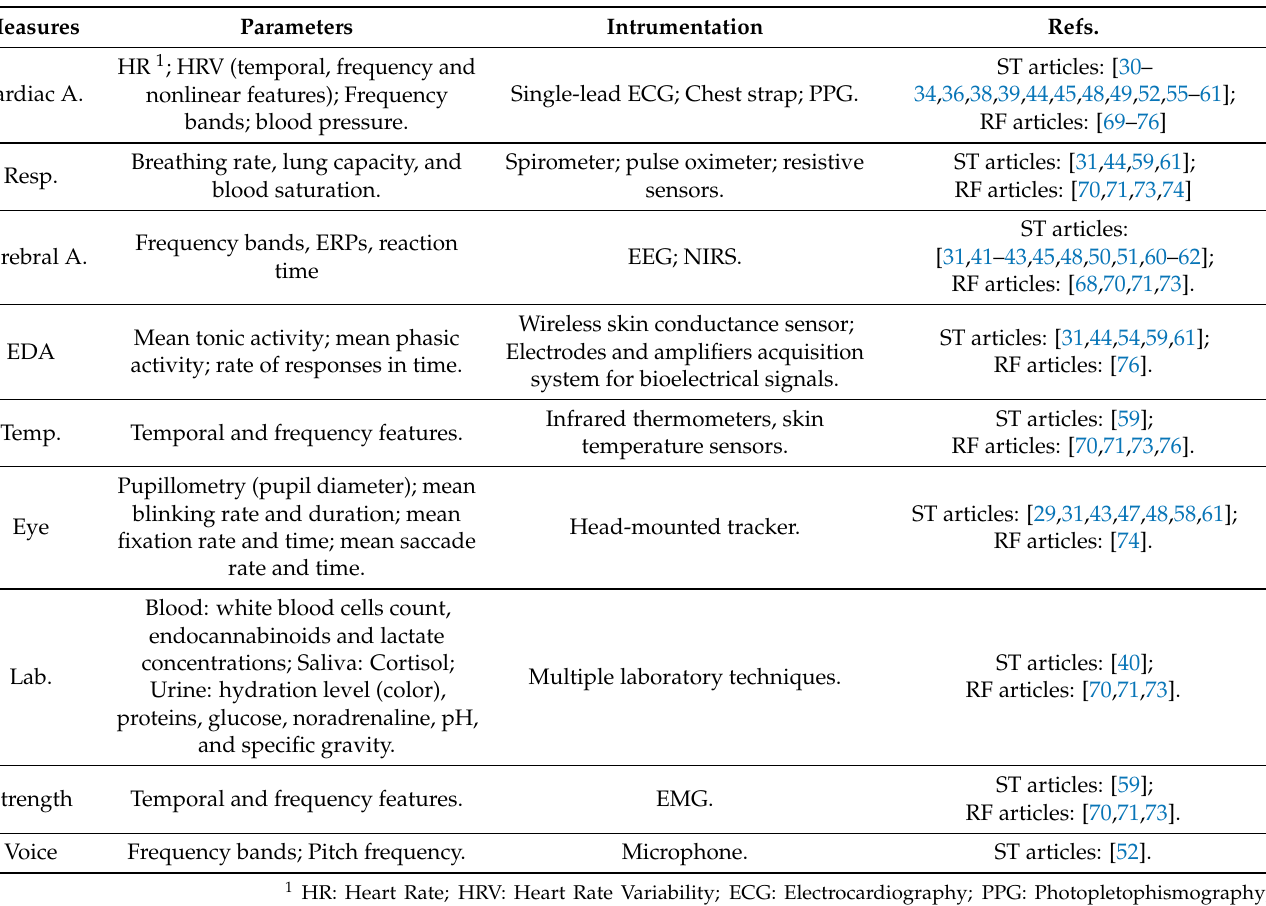
Table 1. Objective Measures performed in the reviewed articles, type of analysis, and instrumentation